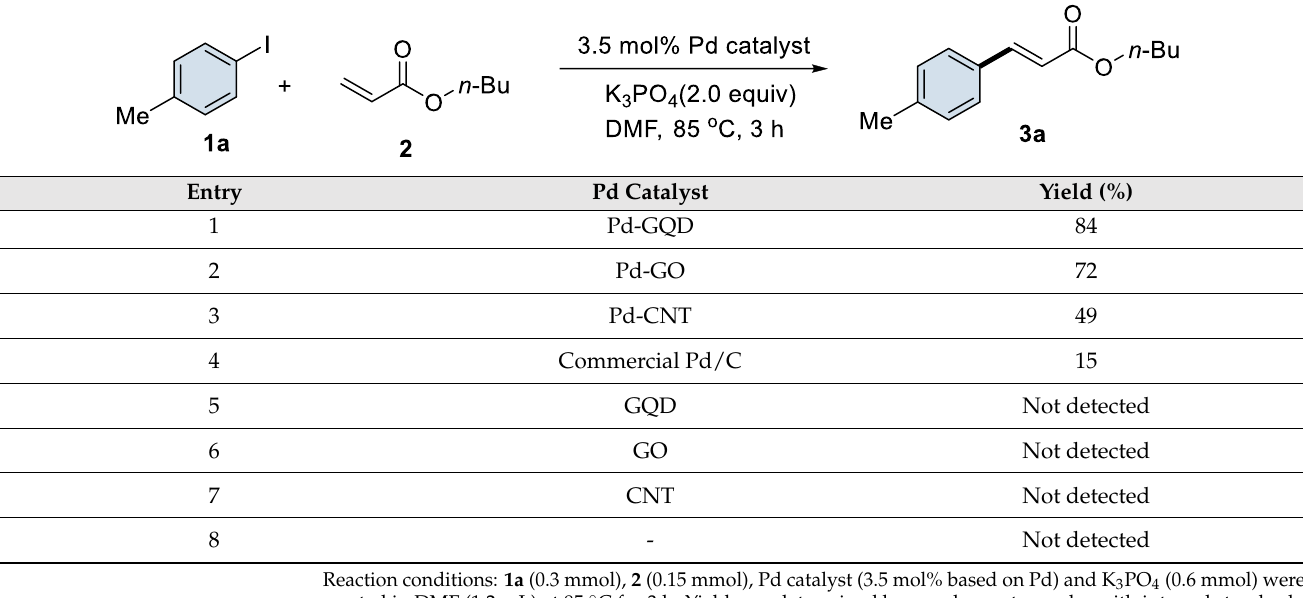
Table 1. Catalytic activities in the Pd-catalyzed Heck cross-coupling reactions.